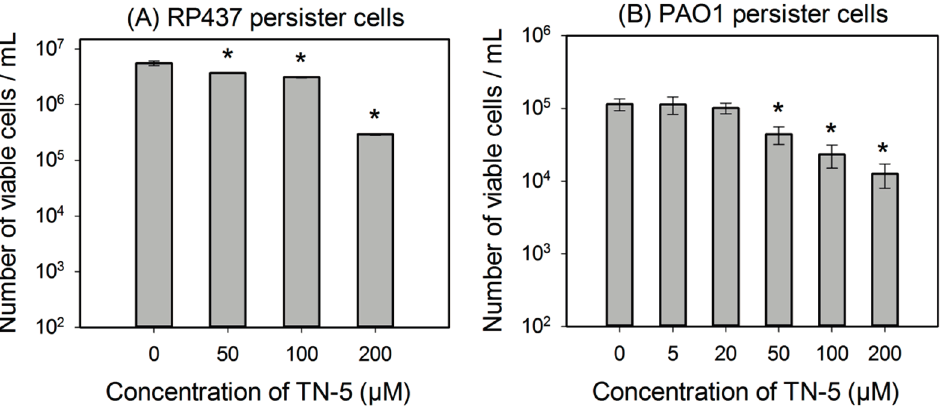
Figure 2. Effects of TN-5 on planktonic cells of E. coli RP437 ( A ), P. aeruginosa PAO1 ( B ), and P. aeruginosa PDO300 ( C ). TN-5 was added in exponential phase cultures at different concentrations and the viability after treatment was determined by counting colony forming unit (CFU). All significant differences (compared to the TN-5 free control) with p < 0.01 are marked with an